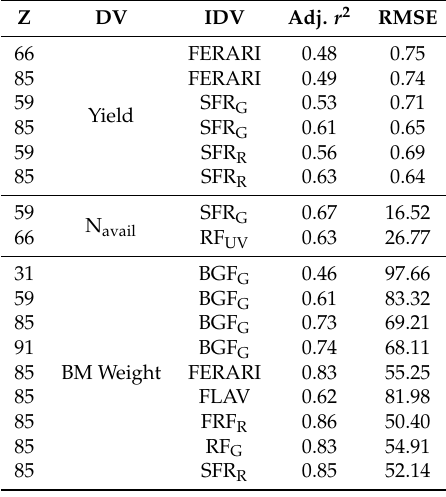
Table 6. Linear regression analysis of signals and ratios from Multiplex ® Research fluorescence sensor for site-year 4. Z = Zadoks’ Scale, DV = Dependent Variable, IDV = Independent Variable, RMSE = Root